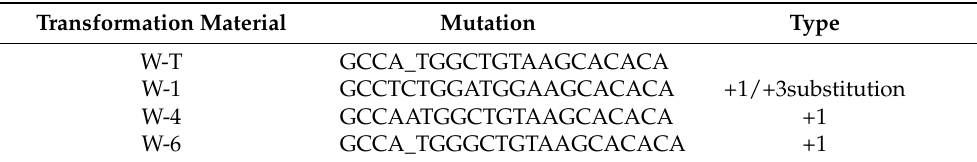
Figure 4. Sequencing results of main T 0 transgenic plants. WT: wild type(Y58S); W-1&W-4&W-6: mutant plants. Table 3. Main mutation types of Wx gene target in Y58S T 0 transformation material of rice. WT: wild type; W-1 and W-4 and W-6: mutant type.